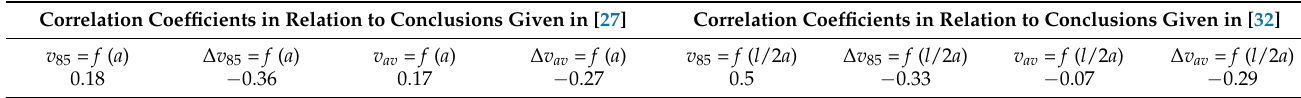
Figure 3. Distribution of free-flow speed ranges on the test sections according to the speed reduction value ∆ v 85 . Table 1. Coefficients of correlation between the vehicle speed after the chicane and reduction in speed ∆ v and the amount of the horizontal shift of traffic lane a and the l /2 a ratio in relation to the test section data. Correlation Coefficients in Relation to Conclusions Given in